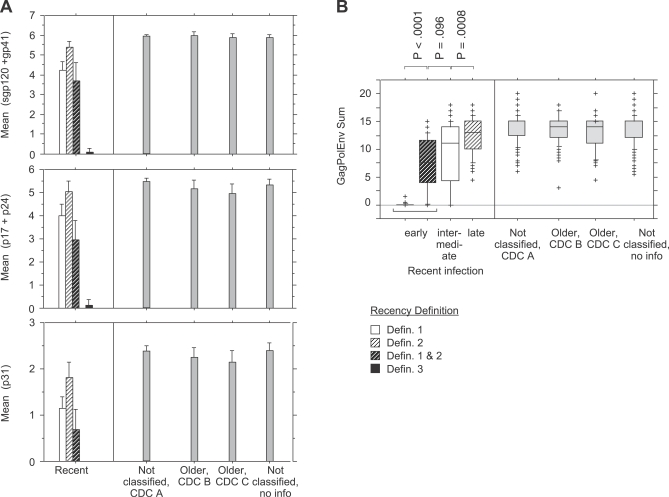
Antibody Reaction as Assessed by the INNO-LIA in Different Groups of Newly Diagnosed HIV-1 Patients(A) Sum of antibody scores to env antigens sgp120 and gp41 (top graph), gag antigens p24 and p17 (middle graph) and pol antigen p31 (bottom graph); bars represent means and error bars their 95% confidence intervals. Reaction is stratified according to recency definitions 1, 2, or 3 and other reported staging information (see Methods).(B) Correct order of recency definitions based on increasing antibody development. Box plots show sum of antibody scores to all five HIV-1 antigen bands. Boxes indicate the median and the 25th and 75th percentile. Horizontal lines located outside of, but closest to the boxes represent the 10th and 90th percentile, respectively. Outliers are plotted individually. The medians of the groups consisting of infections not classified coincide with the 75th percentile (upper limit of box). p-Values on top denote differences between subgroups of recent infections.